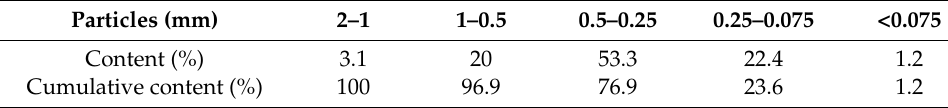
Figure 8. Grading curve and cone resistance of the sand. Table 2. Composition of sand particles.